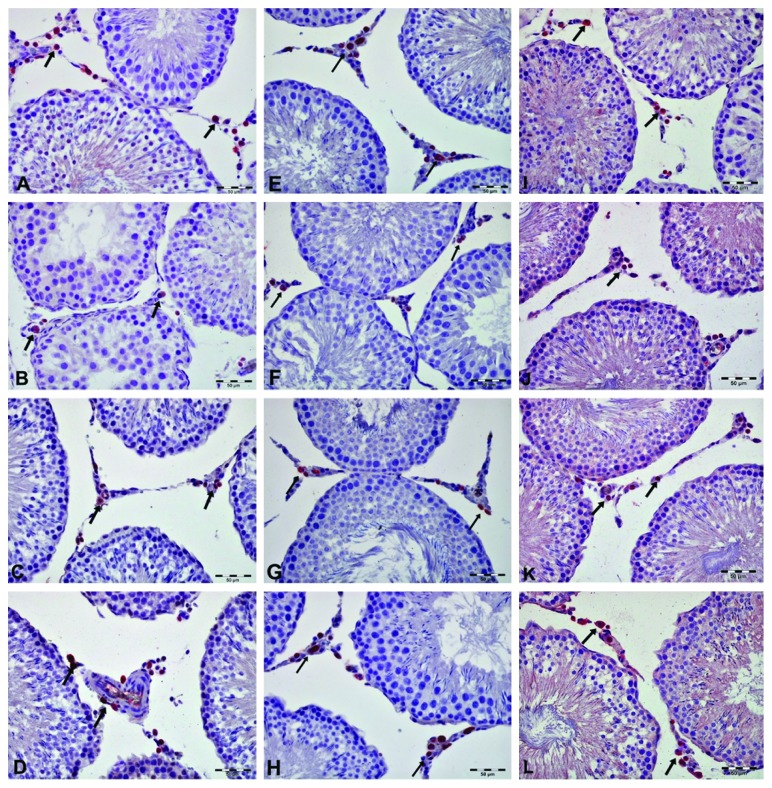
3βHSD, INSL3, and GPRC6A immunoreactivity in testicular tissue samples of postnatal subjects (Group 1). (a) High 3βHSD expression was observed in Leydig cells of control subjects (Group 1A). (b) 3βHSD expression decreased in Leydig cells of GnRH-antagonist-administered subjects (Group 1B). (c) A slight increase in 3βHSD expression was seen in Leydig cells of GnRH-antagonist-and-osteocalcin-administered subjects (Group 1C). (d) Intensive 3βHSD expression was observed in Leydig cells of only-osteocalcin-administered subjects (Group 1D). (e) High INSL3 expression was seen in Leydig cells of control subjects (Group 1A). (f) INSL3 expression decreased in Leydig cells of GnRH antagonist subjects (Group 1B). (g) A decrease in INSL3 expression seemed to continue in Leydig cells of GnRH-antagonist-and-osteocalcin-administered subjects (Group 1C). (h) High INSL3 expression was noticed in Leydig cells of only-osteocalcin-administered subjects (Group 1D). (i) High INSL3 expression was noted in Leydig cells of control subjects (Group 1A). (j) GPRC6A expression decreased in Leydig cells of GnRH-antagonist-administered subjects (Group 1B). (k) A decrease in GPRC6A expression seemed to continue in Leydig cells of GnRH-antagonist-and-osteocalcin-administered subjects (Group 1C). (l) High GPRC6A expression was observed in Leydig cells of only-osteocalcin-administered subjects (Group 1D). Bar = 50 μm.